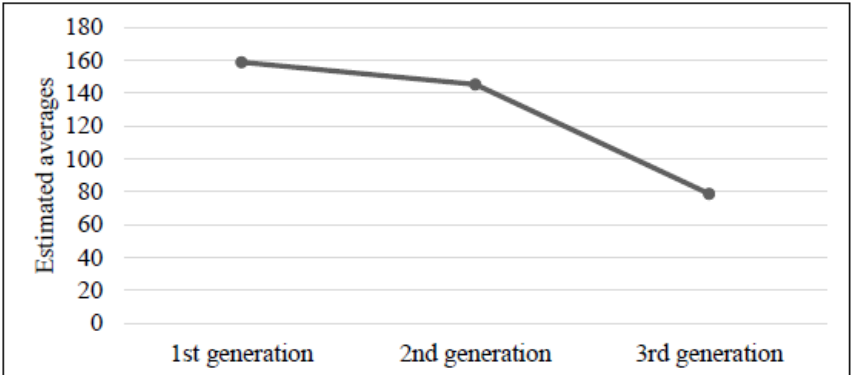
Figure 5. Use of the vamos marker according to the generational group of speakers.